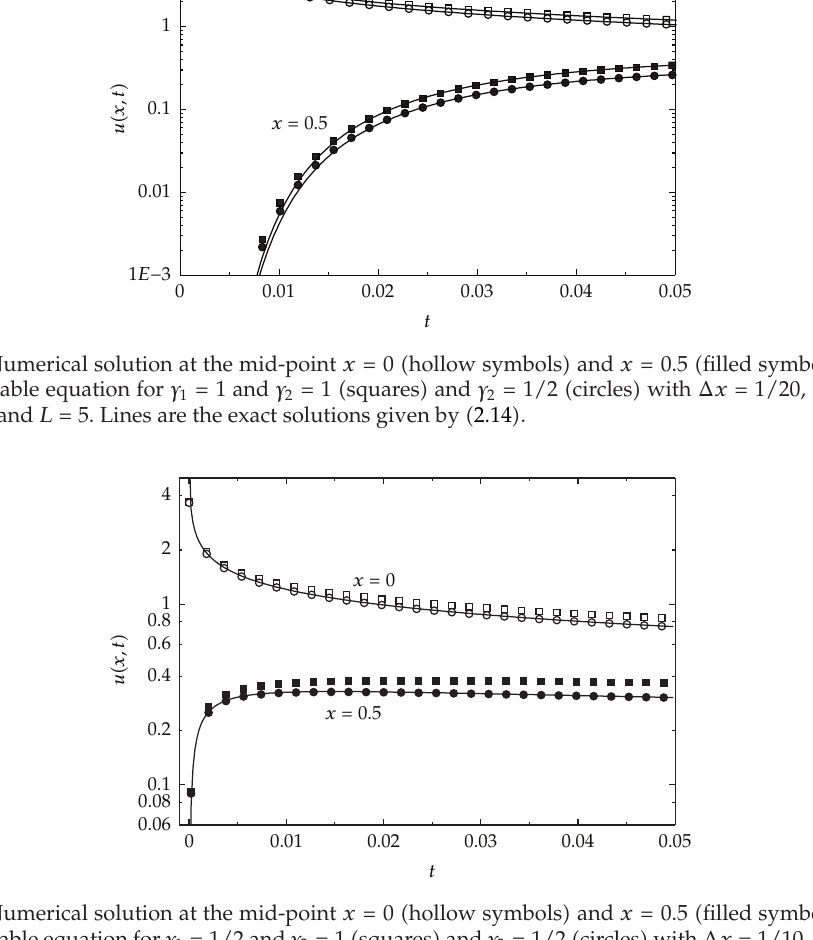
Figure 2: Numerical solution at the mid-point x (cid:7) 0 (cid:5) hollow symbols (cid:6) and x (cid:7) 0 . 5 (cid:5) filled symbols (cid:6) of the fractional cable equation for γ 1 (cid:7) 1 / 2 and γ 2 (cid:7) 1 (cid:5) squares (cid:6) and γ 2 (cid:7) 1 / 2 (cid:5) circles (cid:6) with Δ x (cid:7) 1 / 10, Δ t (cid:7) 10 − 5 , K (cid:7) μ (cid:7) 1, and L (cid:7) 5. Lines are the exact solutions given by (cid:5) 2.14 (cid:6)